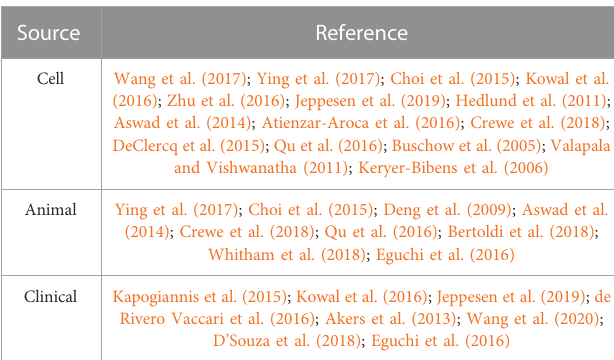
TABLE 1 Summary of EV-related NCD studies and their sources of experimental